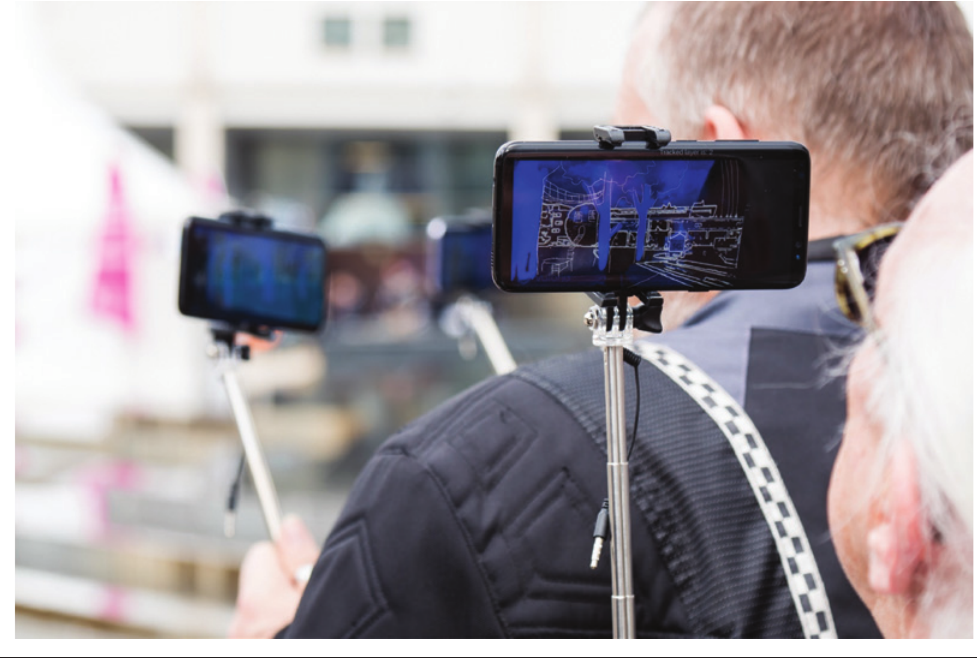
figure 3: Billennium , Uninvited Guests and Duncan speakman, Layered Realities , Millennium square, 2018 (live illustration by sam steer; photograph: Jon